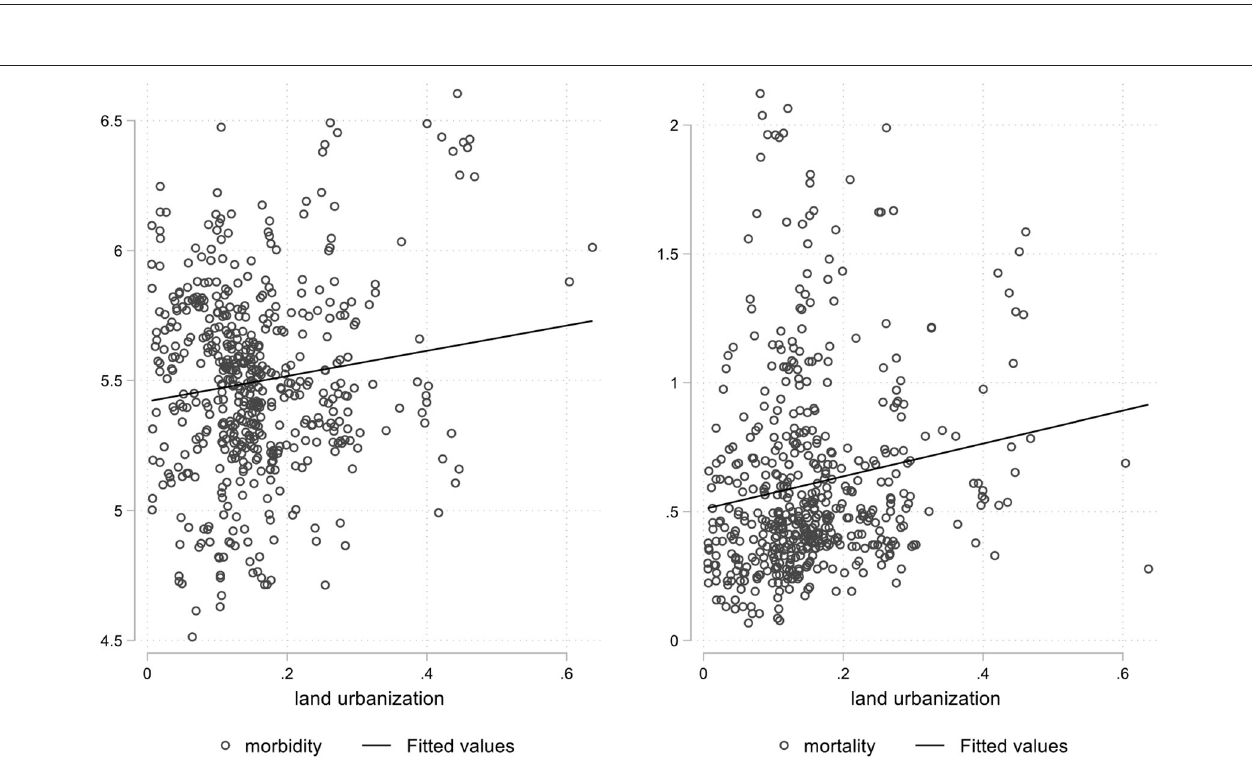
FIGURE 2 | Fitting relationships between land urbanization and the morbidity and mortality.